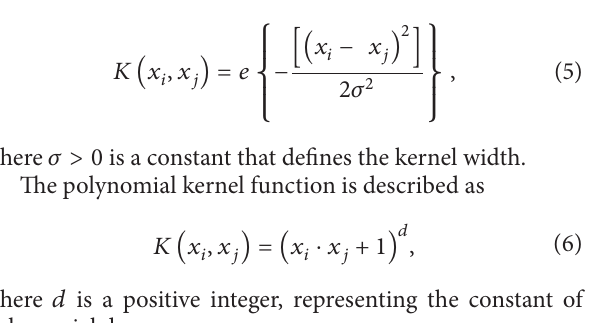
Figure 5: Linearly separable